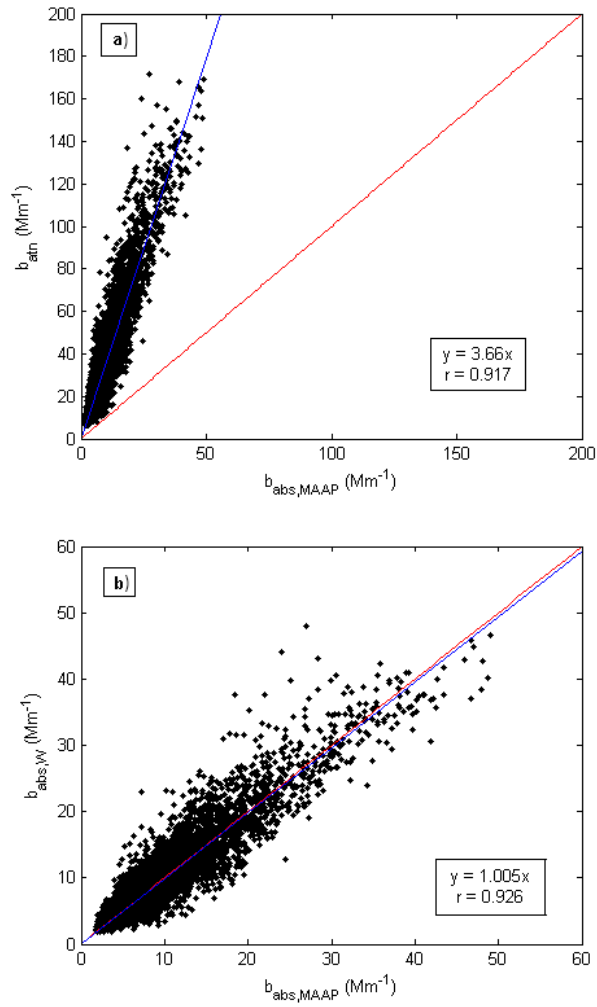
Figure 3. Comparison of the Aethalometer vs. MAAP absorp- tion coefficient ( b abs , MAAP ) at 637nm for (a) non-compensated Aethalometer data ( b ATN ) and (b) Weingartner’s compensation ( b abs , W )